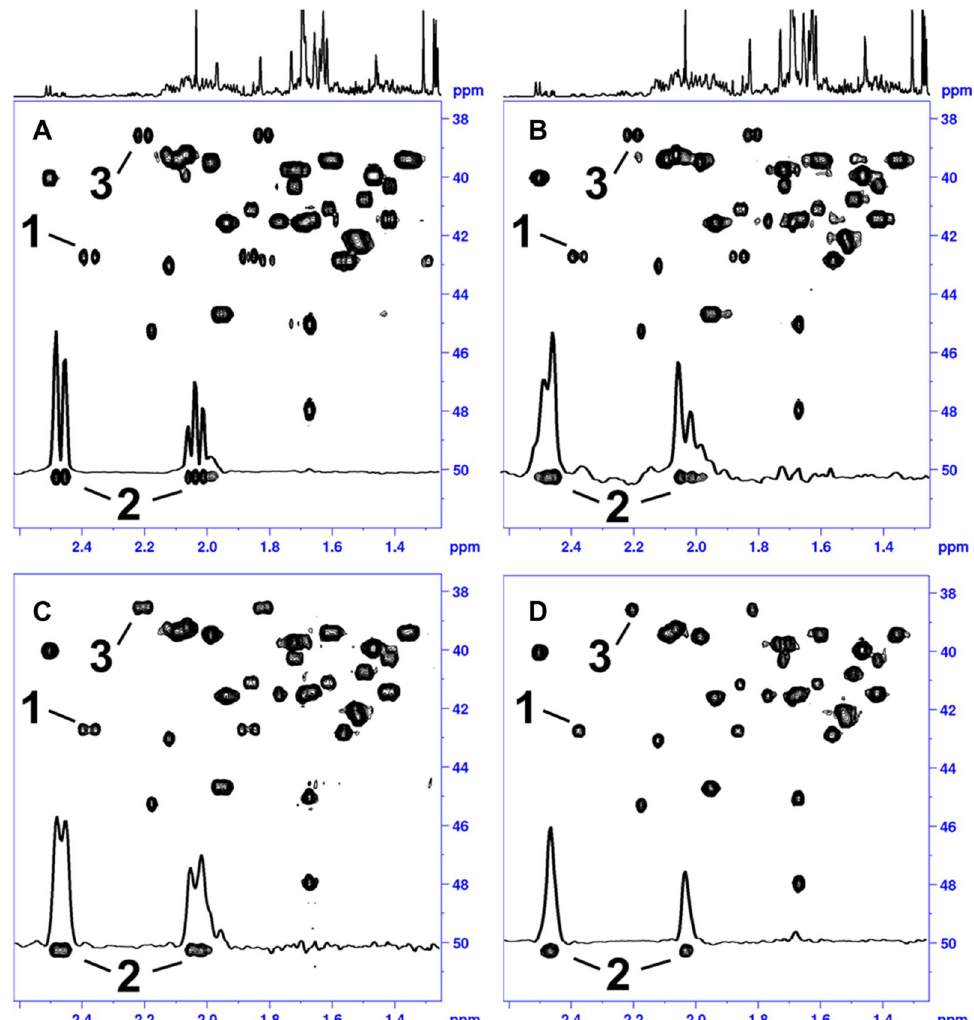
Figure 4. The spectra were collected on a Cannabis Terpene Mix solution in deuterated methanol. The sample was purchased from MERCK SUPELCO as a certified reference material, 2000 μg/mL each component in methanol (TraceCERT). The original Terpene TraceCERT solution was treated with a stream of nitrogen at room temperature to remove the initial methanol solvent and redissolved in Methanol-d 4 prior to be used. The Terpene mix consists of following single Terpene components: beta-Pinene, Camphene, alpha- Pinene, 3-Carene, alpha-Terpinene, (R)-(+)-Limonene, gamma-Terpinene, L-(−)-Fenchone, Fenchol, (1R)-(+)-Camphor, Isoborneol, Menthol, Citronellol, (+)-Pulegone, Geranyl acetate, alpha-Cedrene, alpha-Humulene, Nerolidol, (+)-Cedrol, (−)-alpha Bisabolol. This figure displays an expansion of the spectra of the sample mixture. In ( A ) a standard HSQC with no homodecoupling is shown, ( B ) displays the literature known HD HSQC with BIRD d element using the pulse sequence hsqcetgpsp.2_bbhd (Bruker release version). All 2D HSQC spectra A-C were recorded using NUS employing following parameters: A NUSamount of 40% was chosen to sample the data points in the indirect dimension leading to 204 of 512 complex points. NUS reconstruction was done using compressed sensing (CS) 47–52 . In ( C ) the result of restricted random HD 2D HSQC as described in text is presented and ( D ) shows the fully homodecoupled HSQC spectrum, where all multiplicities are reduced to singlet response. For the 3D experiment the spectral width in direct 1 H dimension was 12,019.2 Hz leading to an acquisition time of 127.7 ms with a physical dwell time of 83.2 us (number of complex points: 1536). The experiment used a 13 C sweep width of 22.64 kHz (t 2 (max) of 22.62 ms with an FID resolution of 44.2 Hz/ point, number of complex points: 512). The 1 H JRES dimension used a sweep width of 100 Hz (t 1 (max) of 160 ms with an